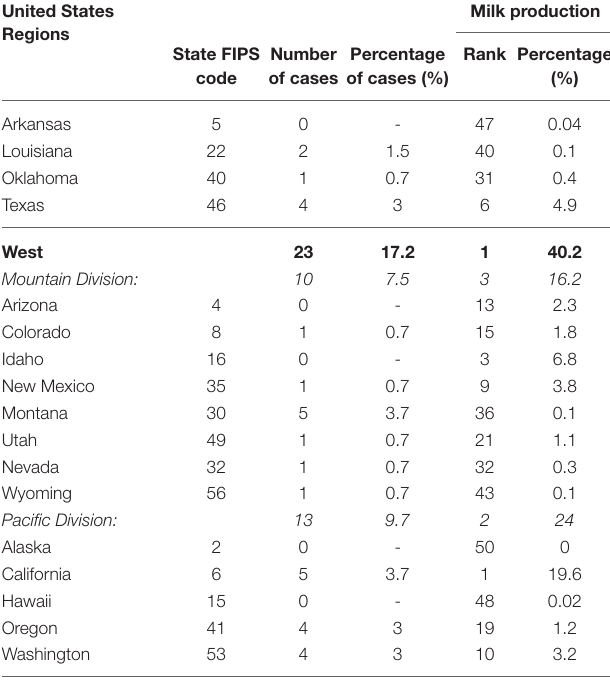
The table denotes the number or percentage representation of the opinion messages included in the study [States (FIPS code) by Division (SPSS Code) by Region (SPSS Code)—not all states were represented in database]. Milk production was also ranked by states or regional division. FIPS, Federal Information Processing Standard. The bold values represent the number of opinion messages per region; percentage of that per region; the rank of each region in milk production; and percentage of milk production per